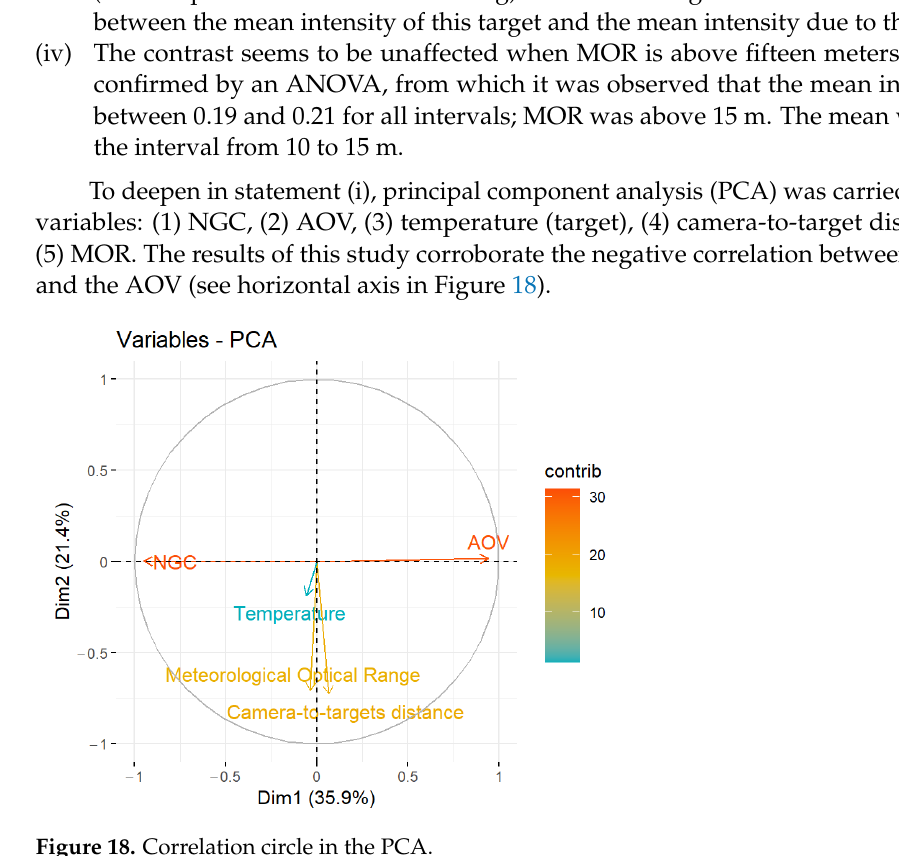
Figure 18. Correlation circle in the